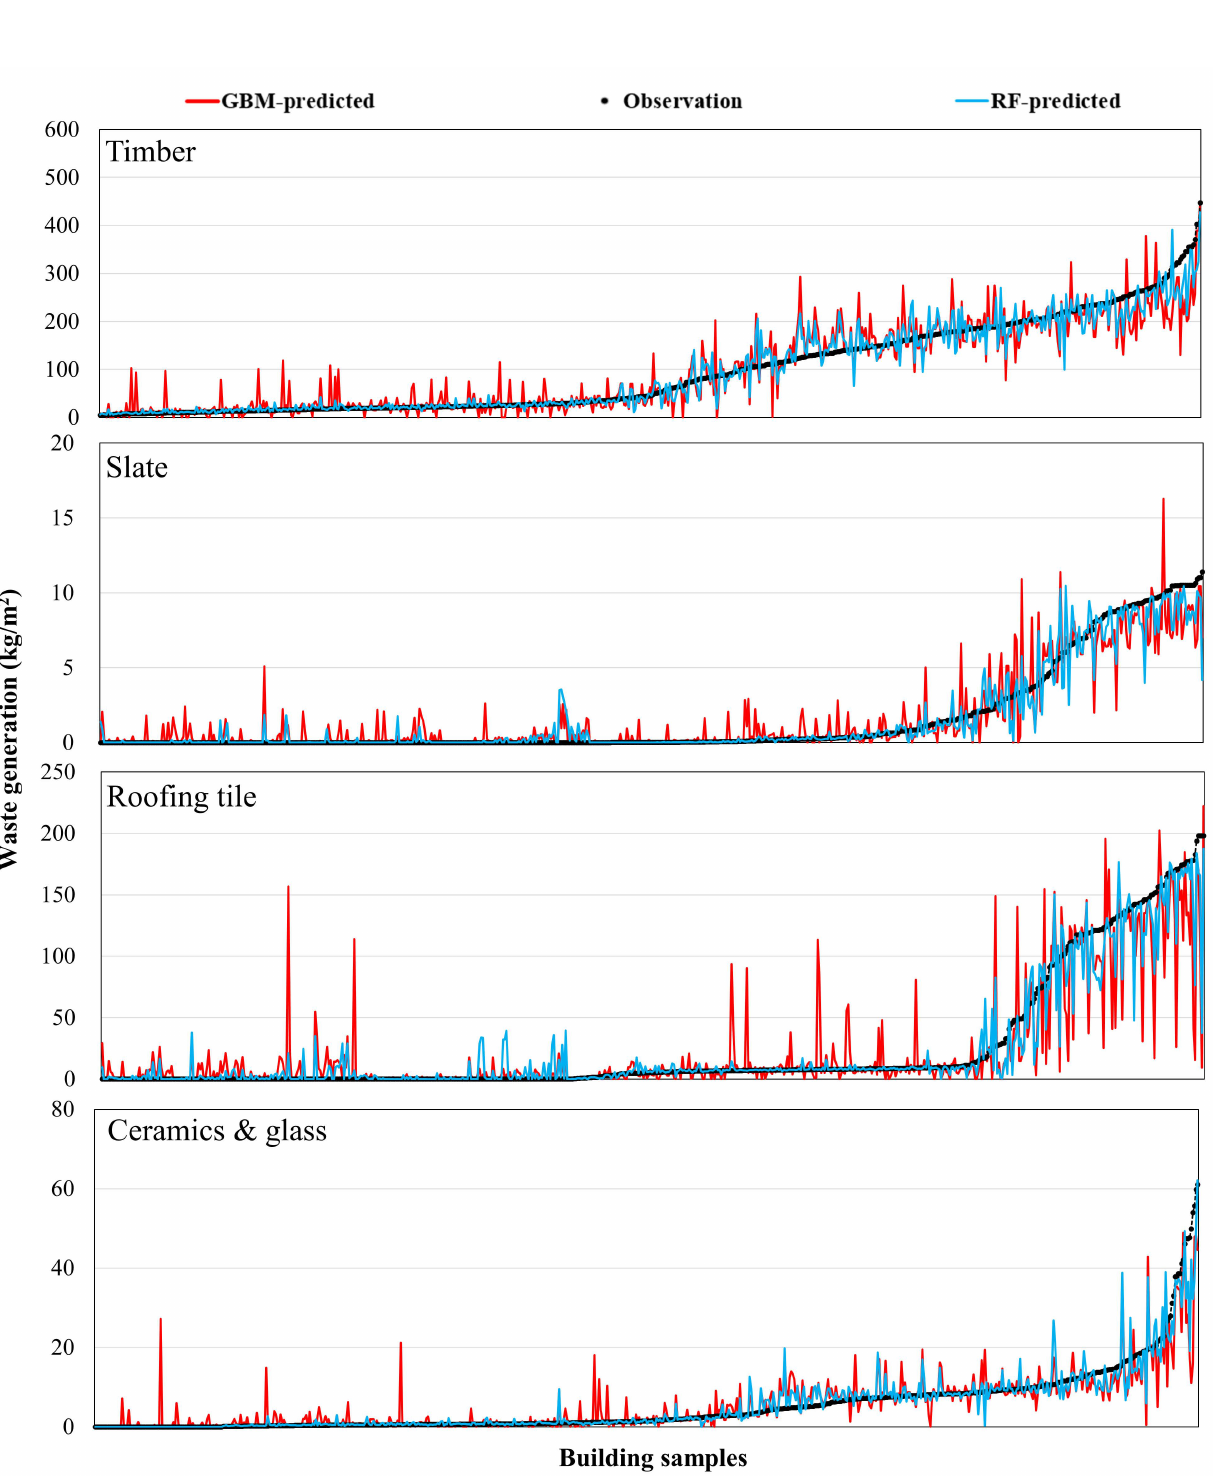
Figure 7. Comparison of the observed and predicted DW generation (kg/m 2 ) with the estimated ML models using RF and GBM for timber, slate, roofing tile, and ceramics &